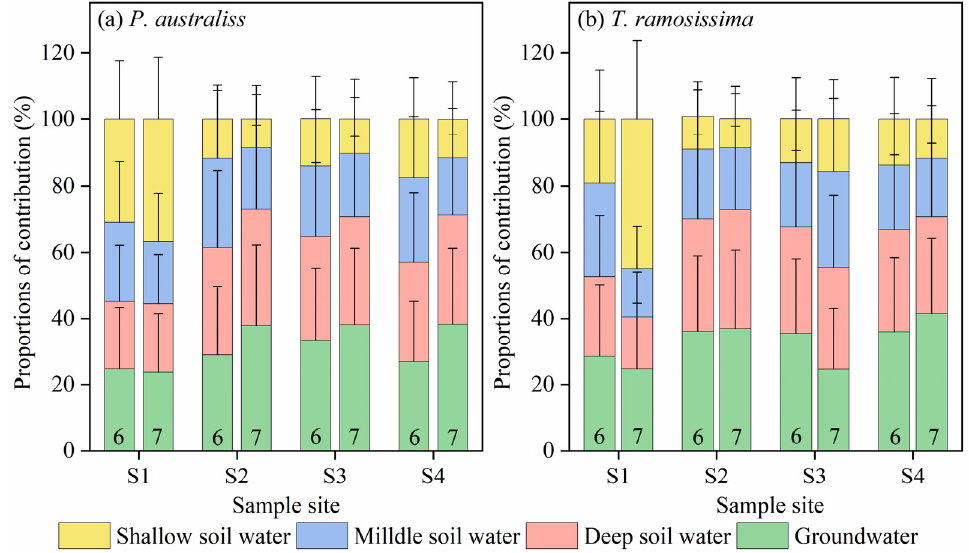
Figure 7. Contribution percentages of potential water sources to T. ramosissima ( a ) and P. australis ( b ). The numbers in the bar chart represent time (months).